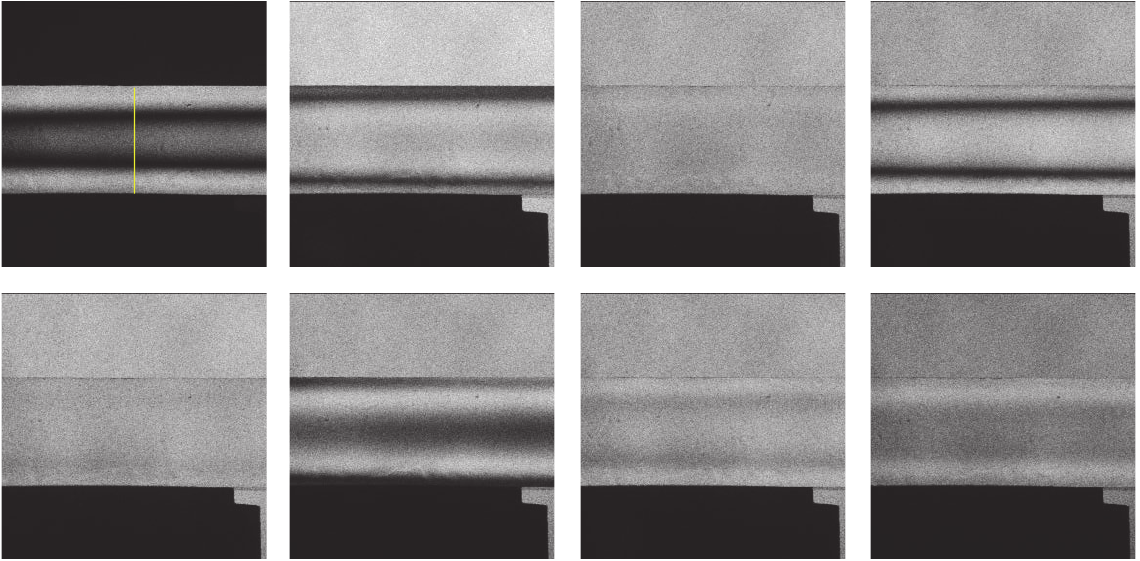
Figure 6: Phase-shifting photoelastic images of monolayer directional